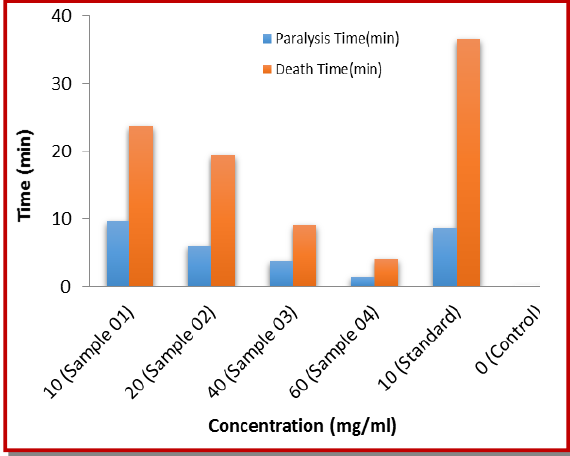
Figure 1: Anthelmintic activity of crude methanolic extract of X. indicum leaves against Phertima posthuma